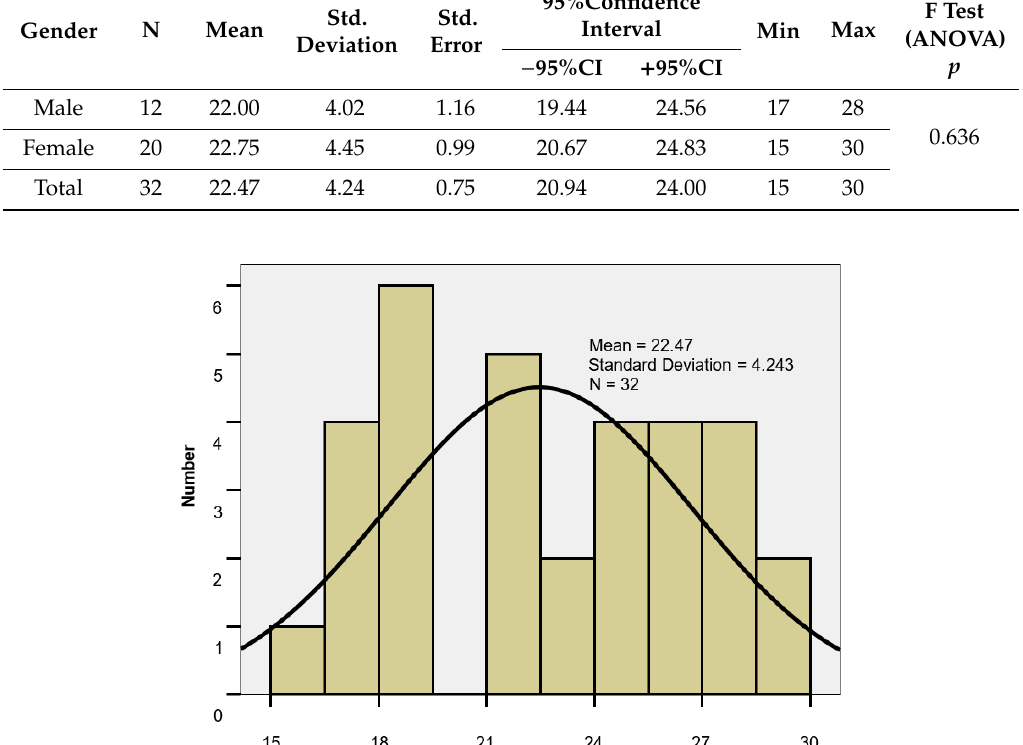
Table 4. Emotional functioning scale.